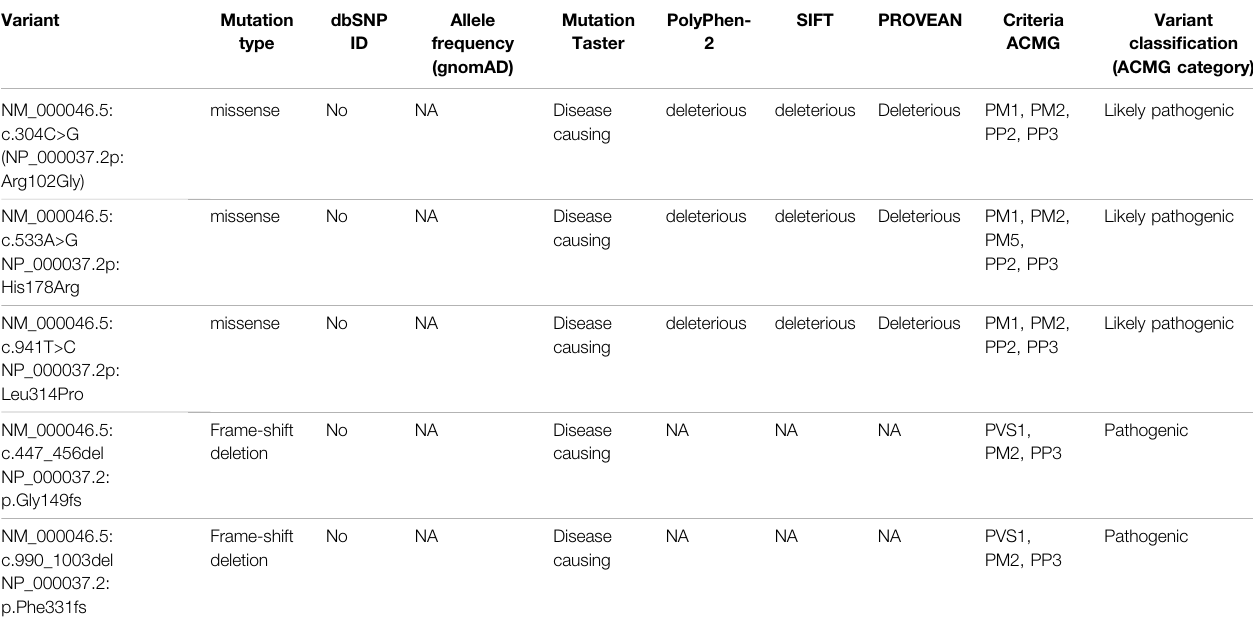
TABLE 2 | Annotation of the novel mutations of the ARSB